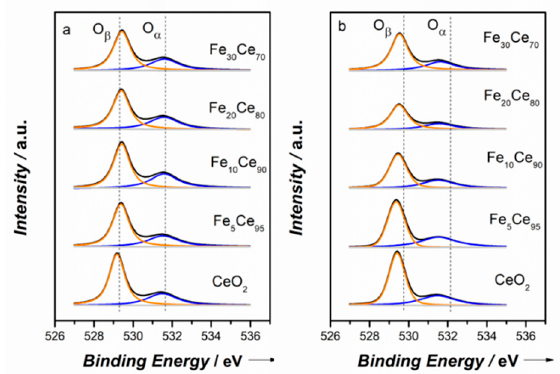
Figure 5. XPS spectra of O1s: ( a ) Co-precipitation method, ( b ) solution combustion synthesis method. Table 2. Curve fitting results of Ce3d and O1s on obtained catalysts.